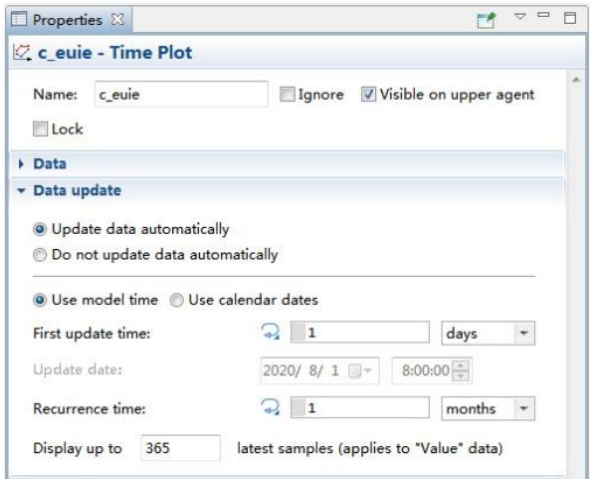
Figure 5. Example command for assignment of building height variable.